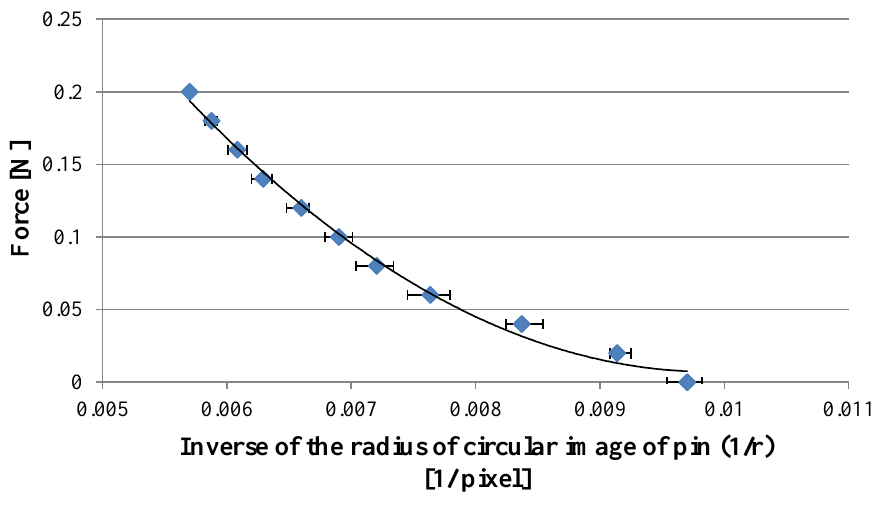
Figure 10. Relationship between applied force and inverse of radius of circular image of